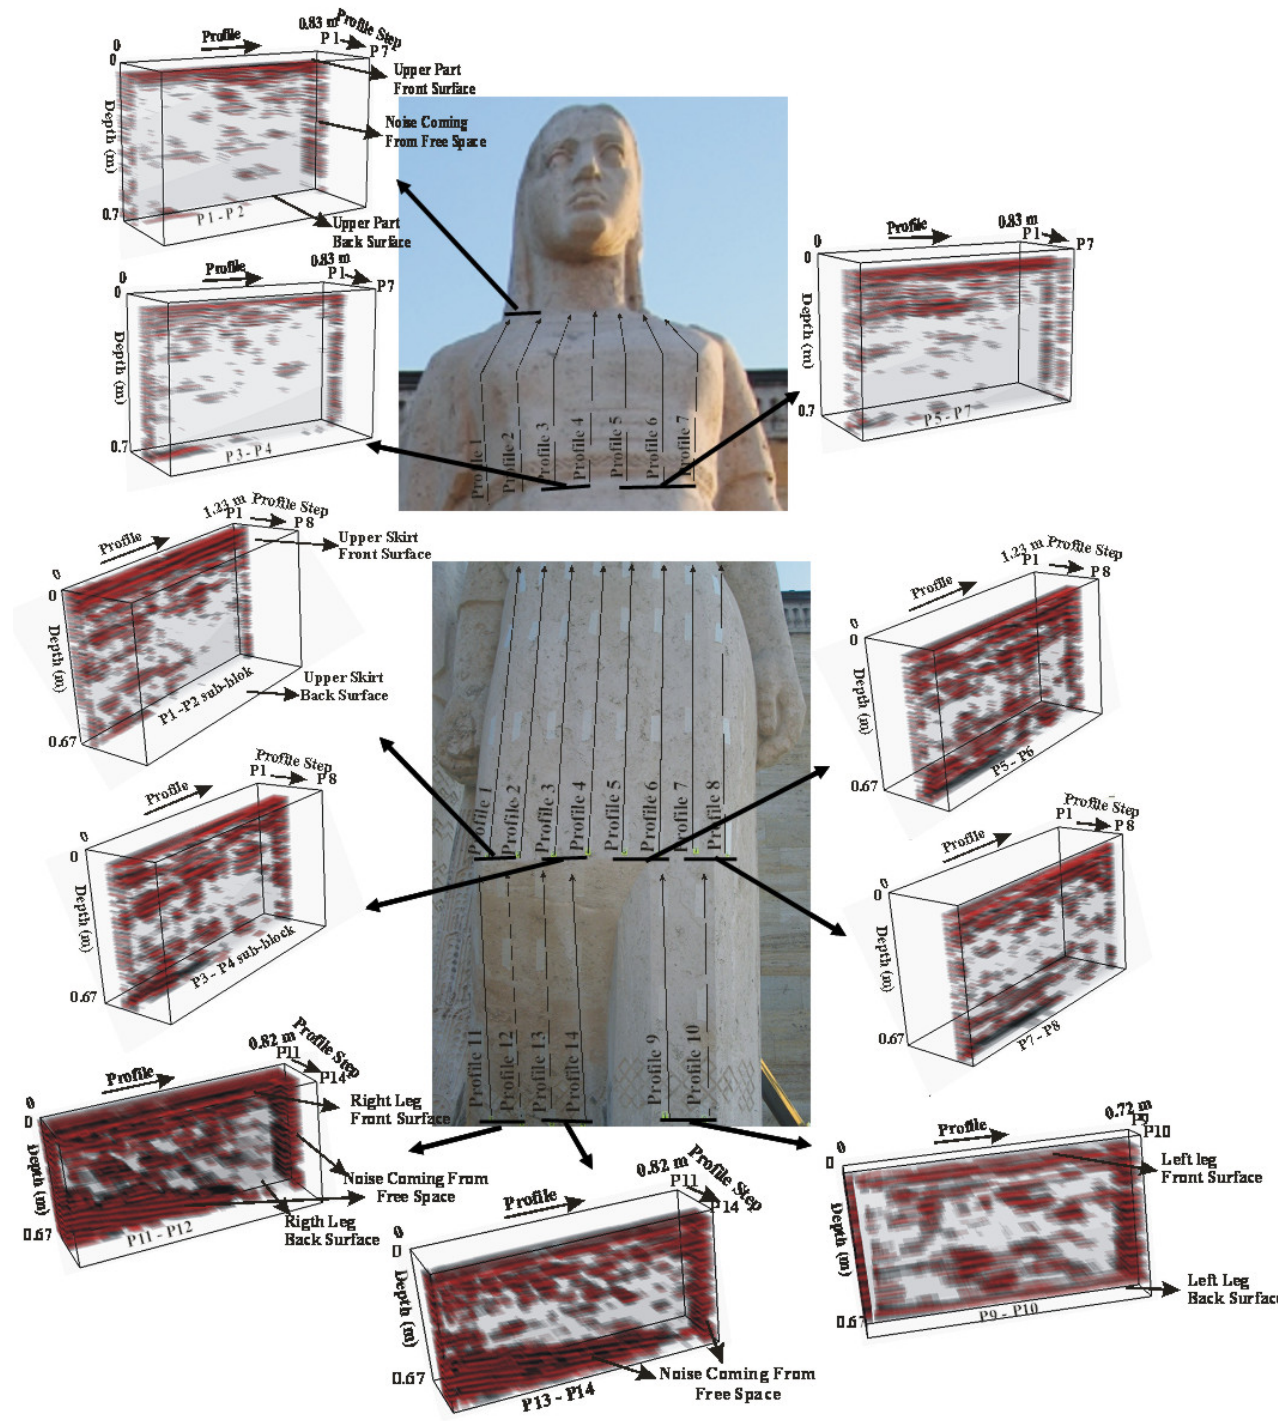
Fig. 12. The transparent 3-D visualization results with the fractures and large cavities of the second woman statue.